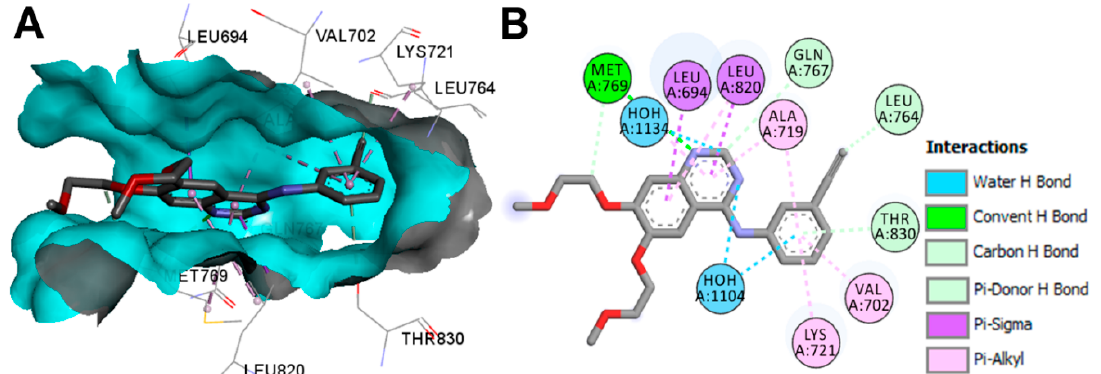
Figure 28. Binding modes of erlotinib (shown as sticks) into the inactive EGFR (pdb: 4HJO): ( A ) 3D binding mode, receptor shown as hydrogen bond surface; ( B ) 2D binding mode showing different types of binding interactions; the figure was generated using Discovery Studio Visualizer (V16.1.0.15350).